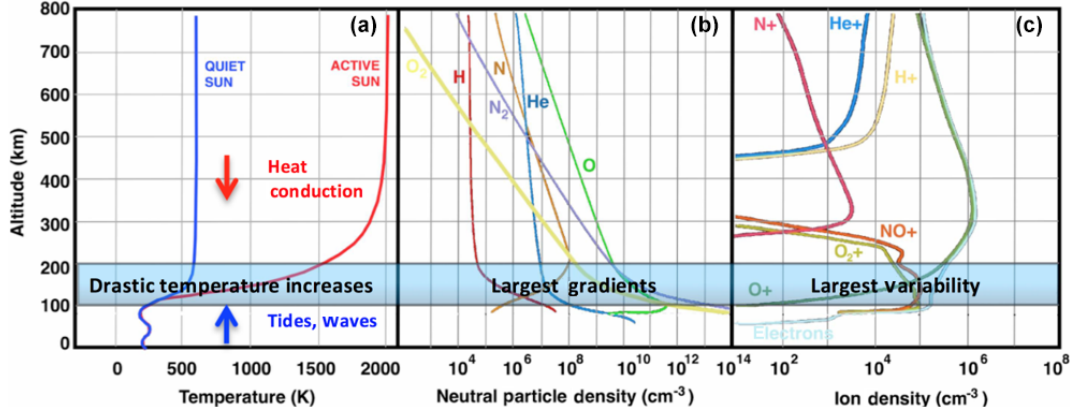
Figure 4. Simulated key variables in the LTI as a function of altitude: temperature at quiet and active solar conditions (a) , neutral (b) and ion (c) constituents. The altitude range from 100 to 200km shows the largest rates of change in most